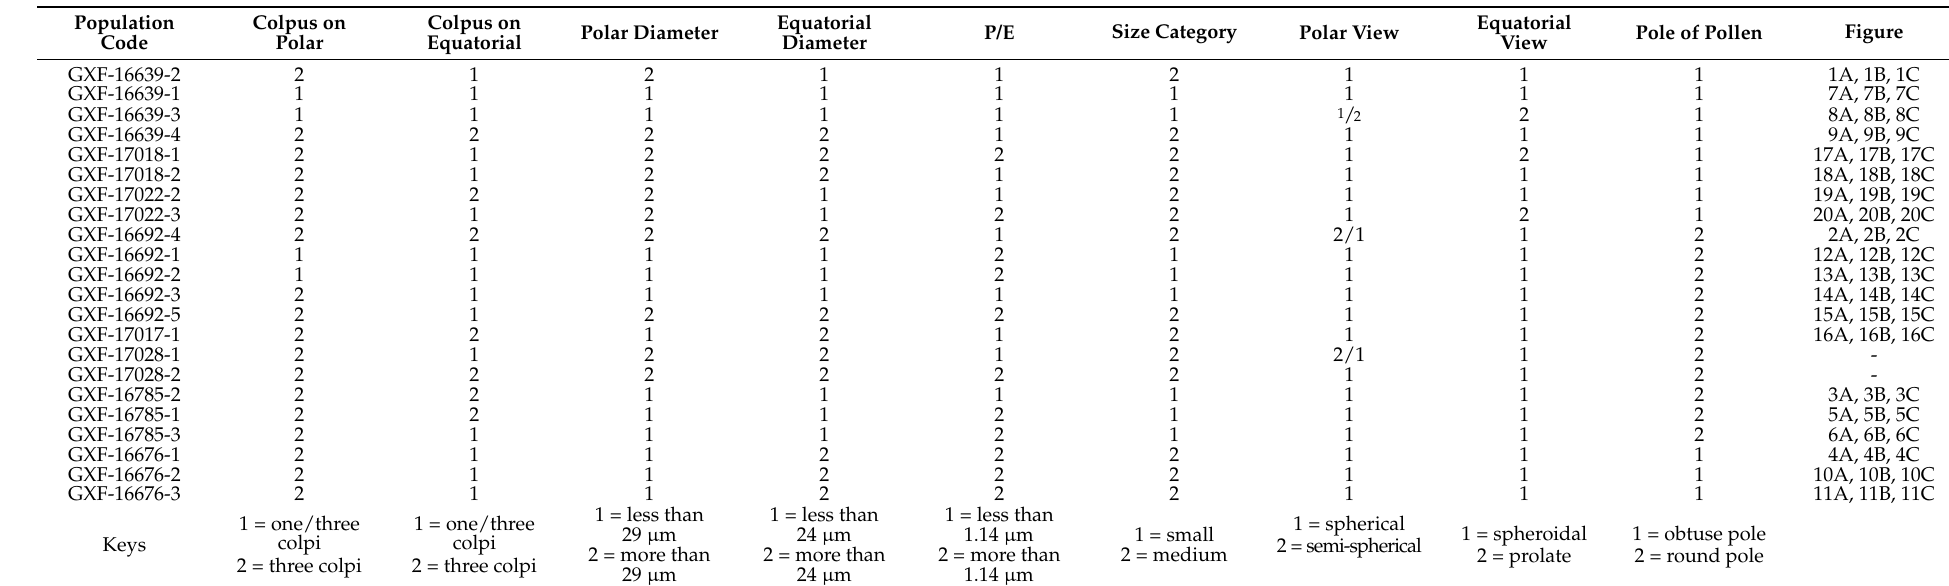
Table 5. Morphological variation within different populations of R. sericea complex